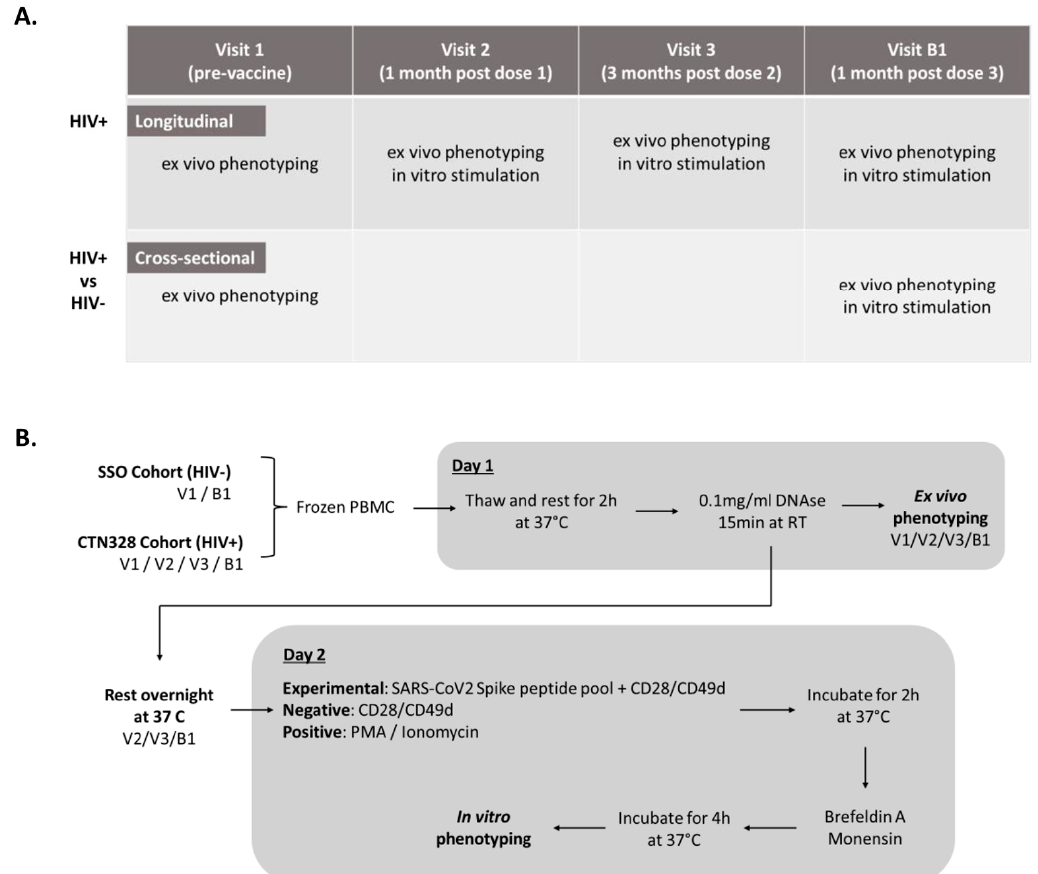
Figure 1. Experimental setup. ( A ) Longitudinal analysis was performed on blood cells collected during Visit 1 (V1; pre-vaccination), Visit 2 (V2; 1 month post 1st dose), Visit 3 (V3; 3 months post 2nd dose), and Visit B1 (B1; 1 month post 3rd dose) in people living with HIV (PLWH). Cross-sec- tional comparisons between PLWH and seronegative controls were made on samples collected at Visits 1 and B1 only. ( B ) Frozen PBMCs were thawed, rested at 37 °C for 2 h, incubated with DNAse I for 15 min at RT, and stained with ex vivo flow cytometry phenotyping panels. In total, 10 6 PBMCs per experimental condition were rested at 37 °C overnight and then stimulated with CD28/CD49d co-stimulatory antibodies in presence or absence of SARS-CoV2 Spike peptides for 6 h. Each sample batch included two positive controls stimulated with PMA/Ionomycin. Brefeldin A and Monensin were added 4 h before the end of